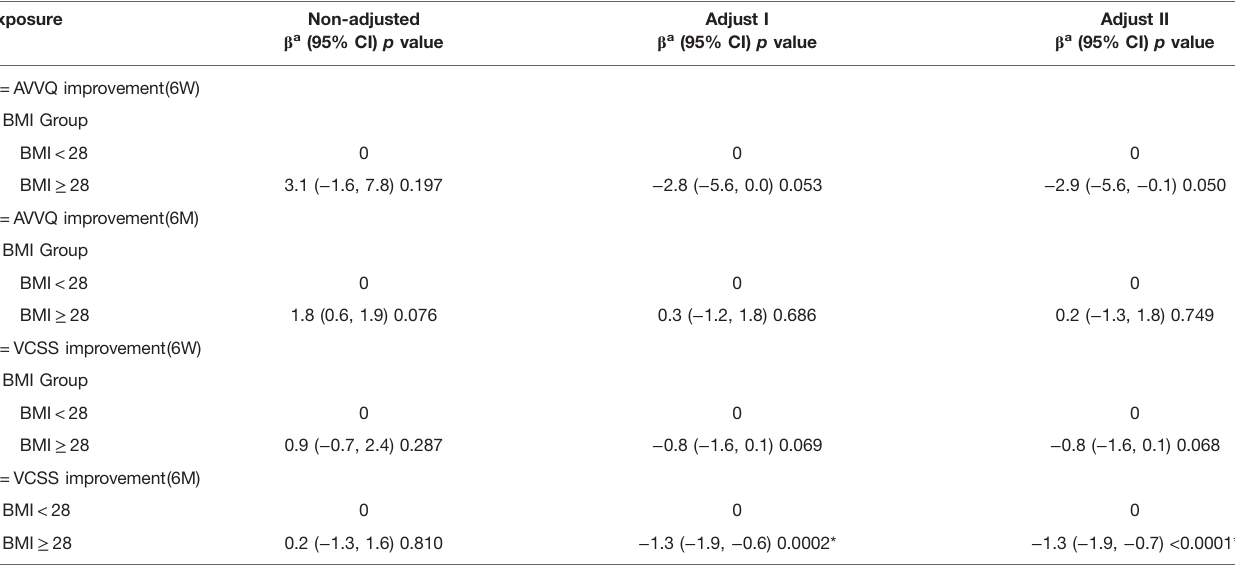
TABLE 4 | Multivariate logistic regression model for risk factors associated with the improvement of AVVQ and VCSS at six weeks and six months after surgery.